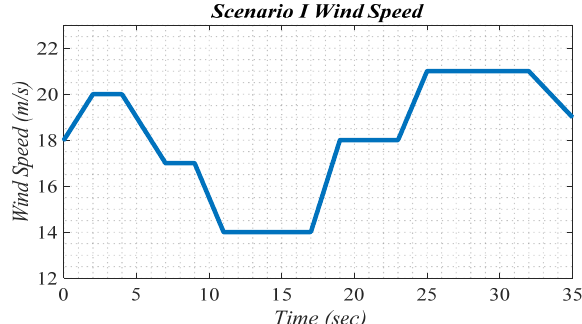
Figure 6. Step distribution of wind speed.